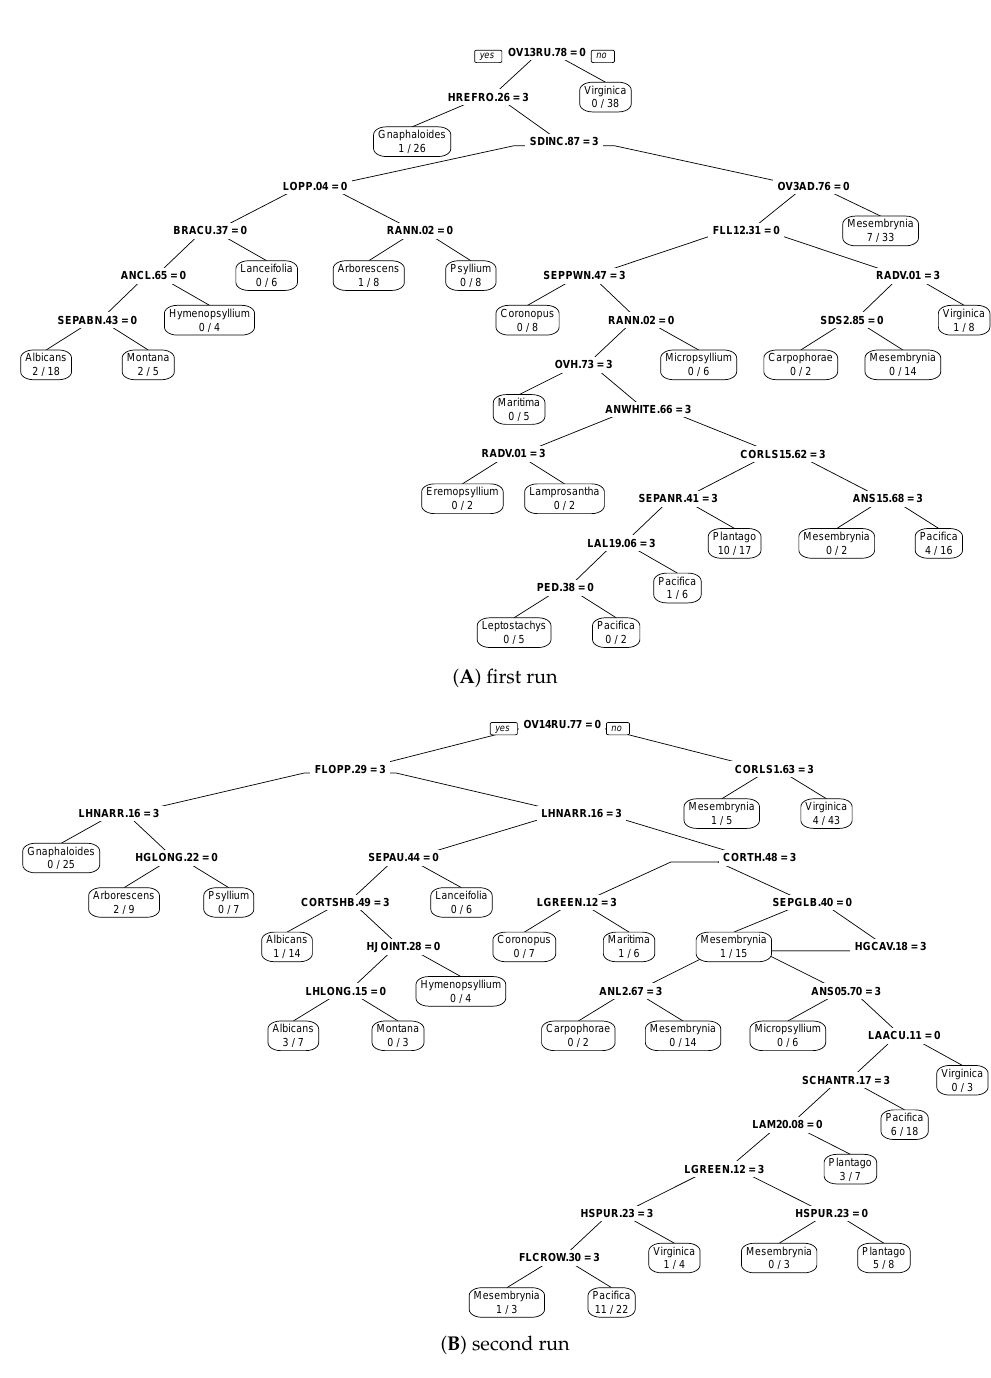
Figure 10. Recursive partitioning of Plantago sections with morphological characters, prototype of diagnostic key: ( A ) first run and ( B ) second run on binary morphological characters. Character abbreviations explained in Table